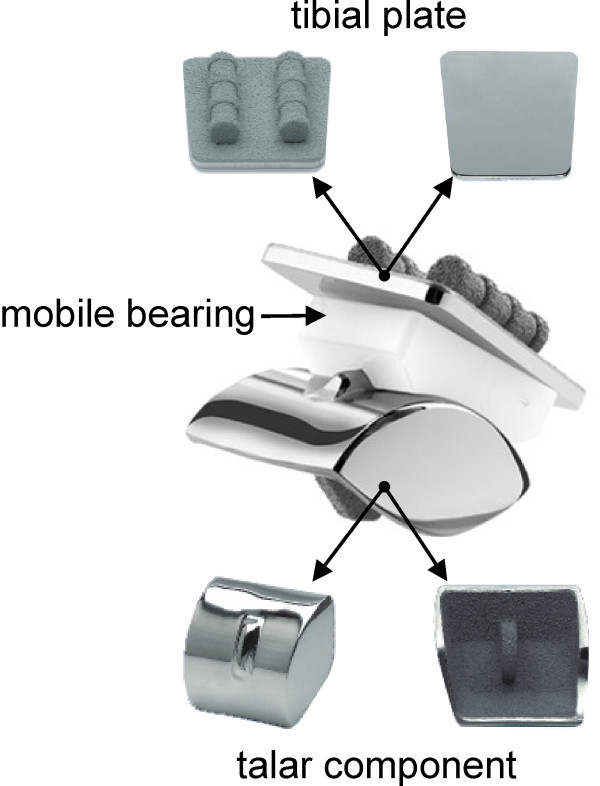
S.T.A.R.® system [19].